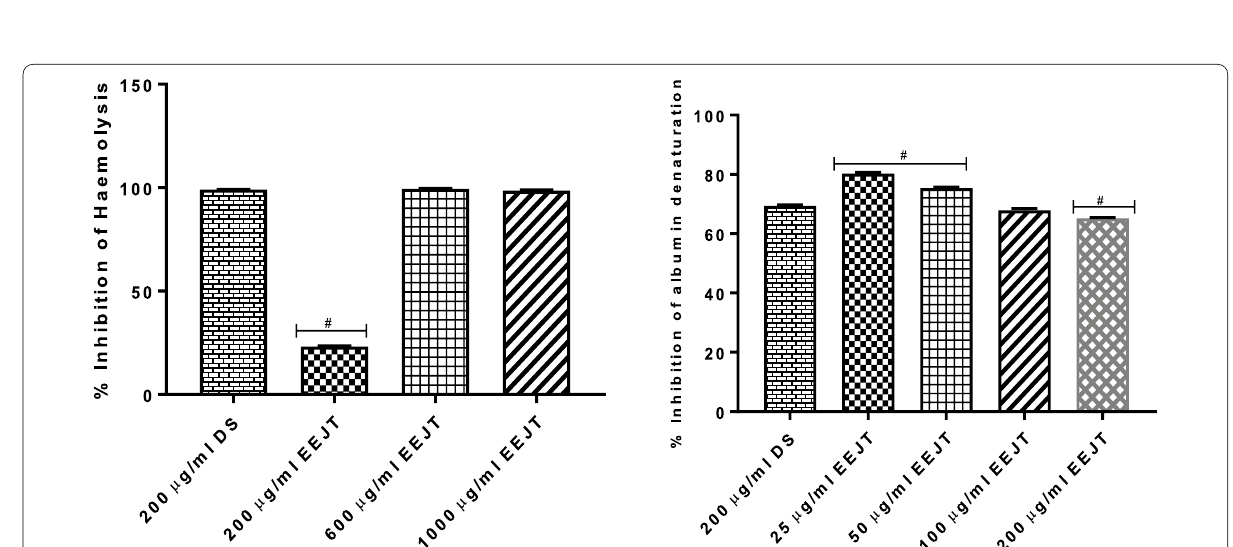
Fig. 7 In vitro anti-inflammatory potential of ethanol extract of Jatropha tanjerensis leaves ( a ) hypotonicity induced haemolysis of erythrocyte ( b ) Albumin denaturation. # P < 0.05, significant compared to 200 µg/ml of Diclofenac sodium